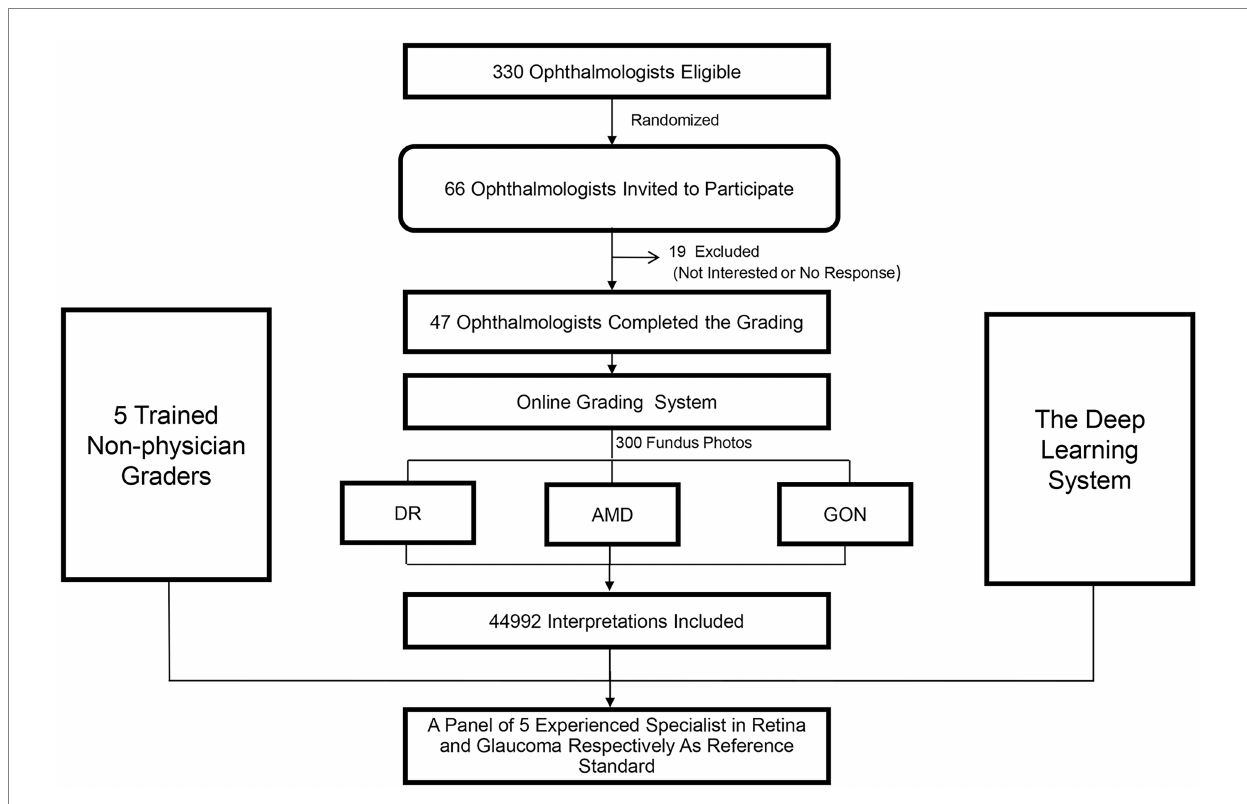
FIGURE 1 Recruitment, workflow, and grading of ophthalmologists and non-physician